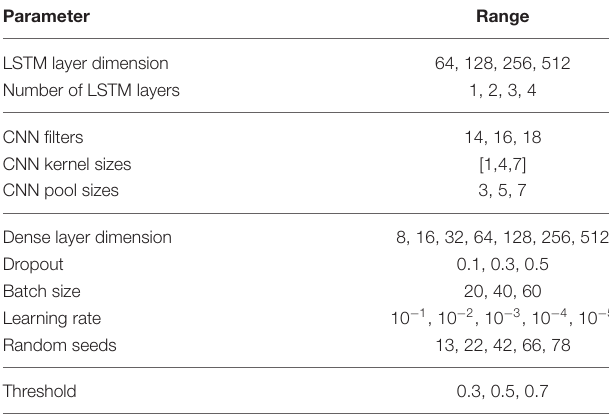
TABLE 3 | Tested value ranges included in the hyper-parameter search for our multi-modal machine learning